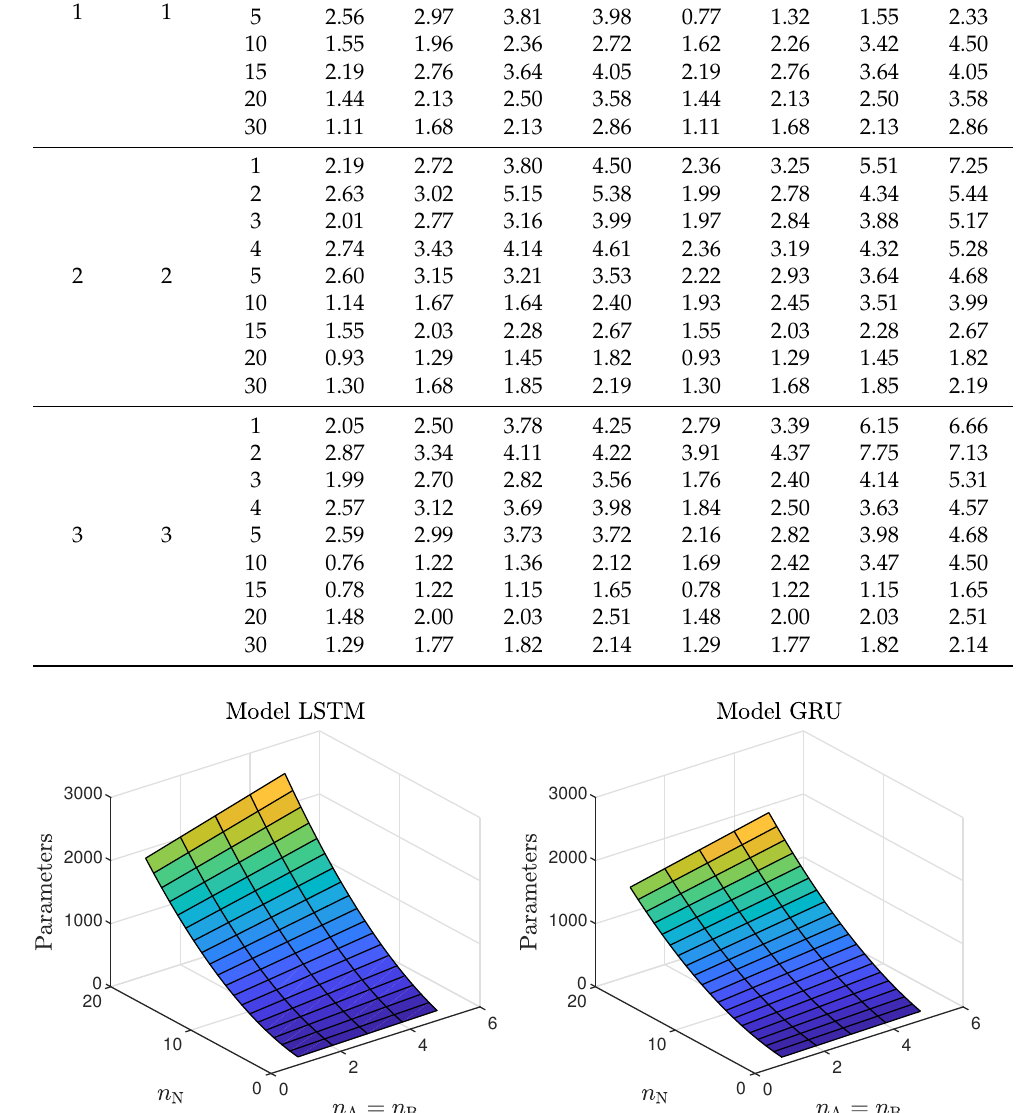
Figure 6. The number of the parameters of the LSTM and GRU models as a function of the number of neurons and the order of the dynamics determined by n A = n B